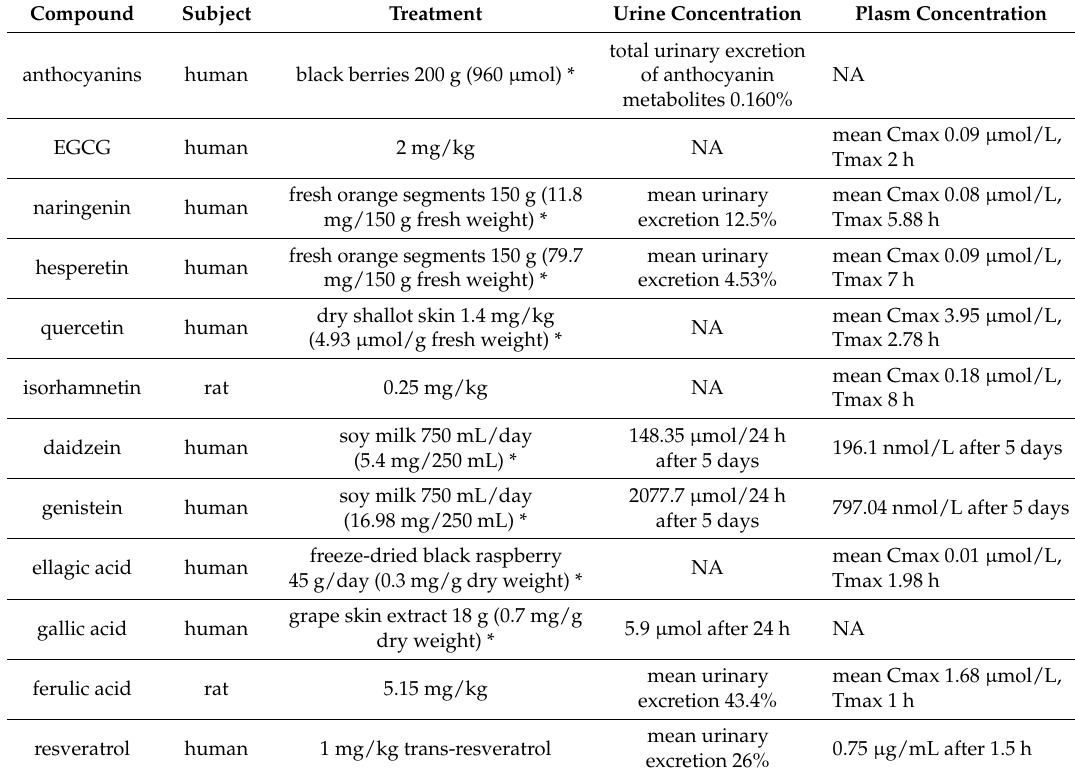
Table 5. The bioavailability of some natural polyphenols.